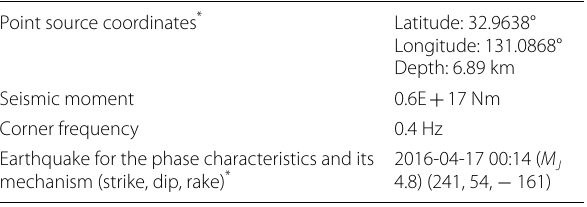
Table 2 Parameters of the simulation for the earthquake of 2016/04/16 03:03 (M w